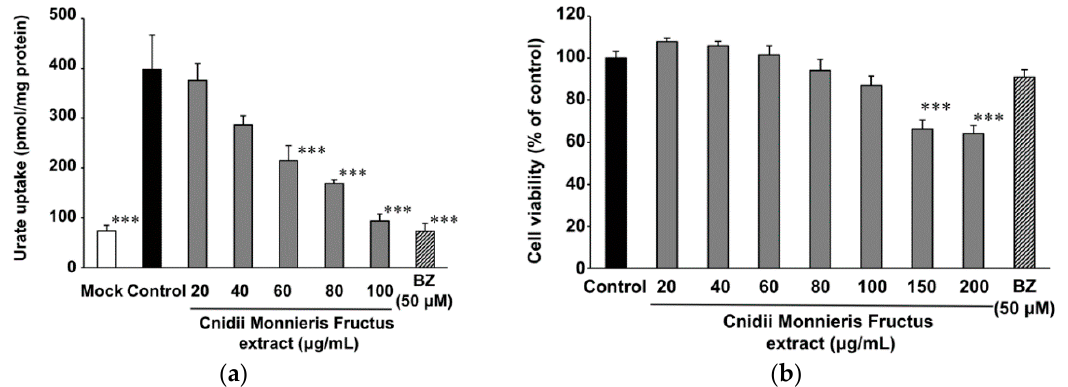
Figure 2. Effect of Cnidii Monnieris Fructus extract on the uptake of uric acid via URAT1. ( a ) HEK293/PDZK1 cells were transiently transfected with human URAT1. Cells were incubated with uric acid (11.6 µM) with or without the extract at 37 °C for 30 min, and the uptakes of uric acid into the cells were measured. Data are expressed as the mean ± S.E. ( n = 3). ( b ) Cytotoxicity of Cnidii Monnieris Fructus extract was measured using the MTT method. Data are expressed as the mean ± S.E. ( n = 6). Benzbromarone (BZ, 50 µM) was used as a positive control. *** p < 0.001 vs. the control group by analysis of variance (ANOVA) and Bonferroni–Dunnett’s multiple t -test.